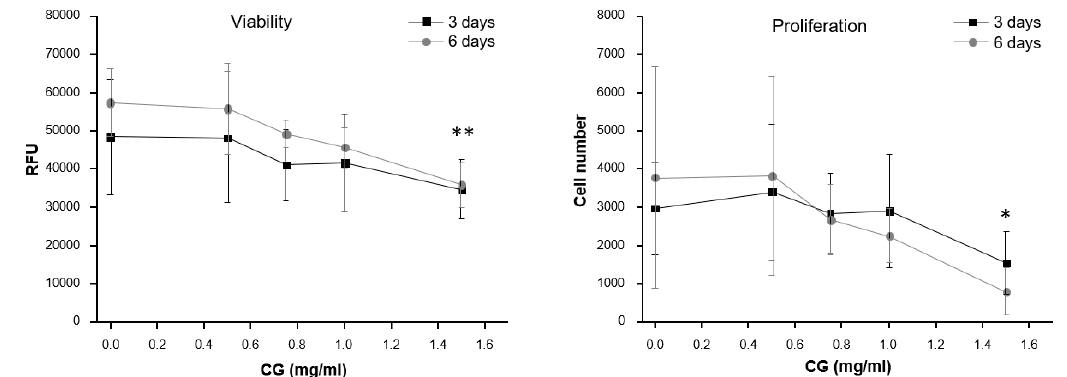
Figure 1. Human chondrocyte viability (left) and proliferation (right) at di ff erent CG concentrations. CG 1.5 mg / mL induces a significant decrease in viability (** p ≤ 0.001) and proliferation (* p ≤ 0.05), with respect to control (no CG) only after 6 days of treatment. No significant di ff erences were observed, at any concentration, between data collected at 3 and 6 days of exposure. CG a ff ected neither the expression of matrix-degrading enzymes ( MMP1 and MMP3 ) nor that of their inhibitors ( TIMP1 and TIMP3 ) (Figure 2).